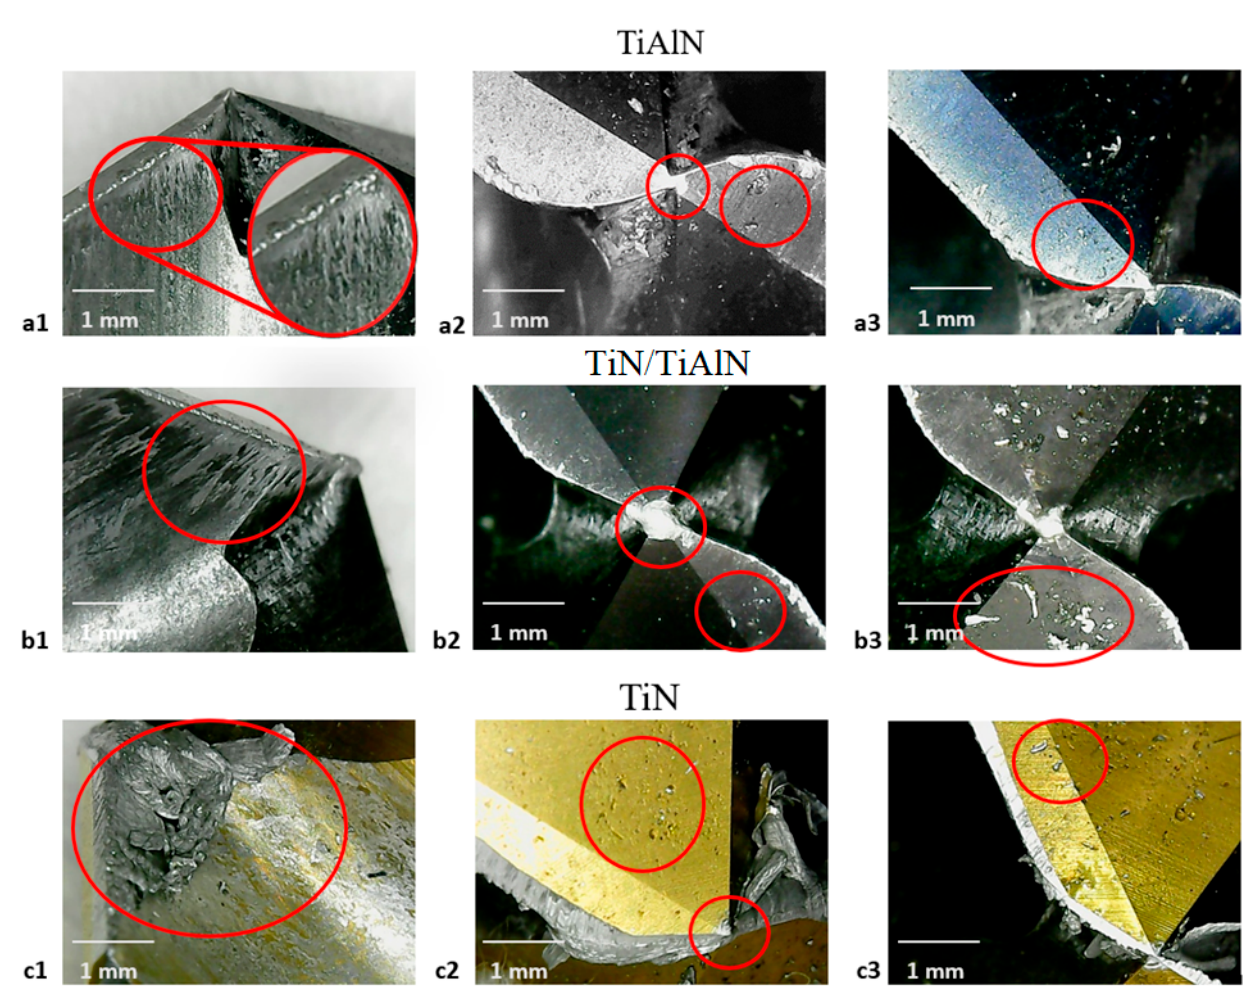
Figure 11. ( a1 , b1 , c1 ) Built-up edge and aluminum spread adhesion; ( a2 , b2 , c2 ) surface pitting and aluminum build-up on tool’s tip; ( a3 , b3 , c3 ) aluminum filling the surface pitting.